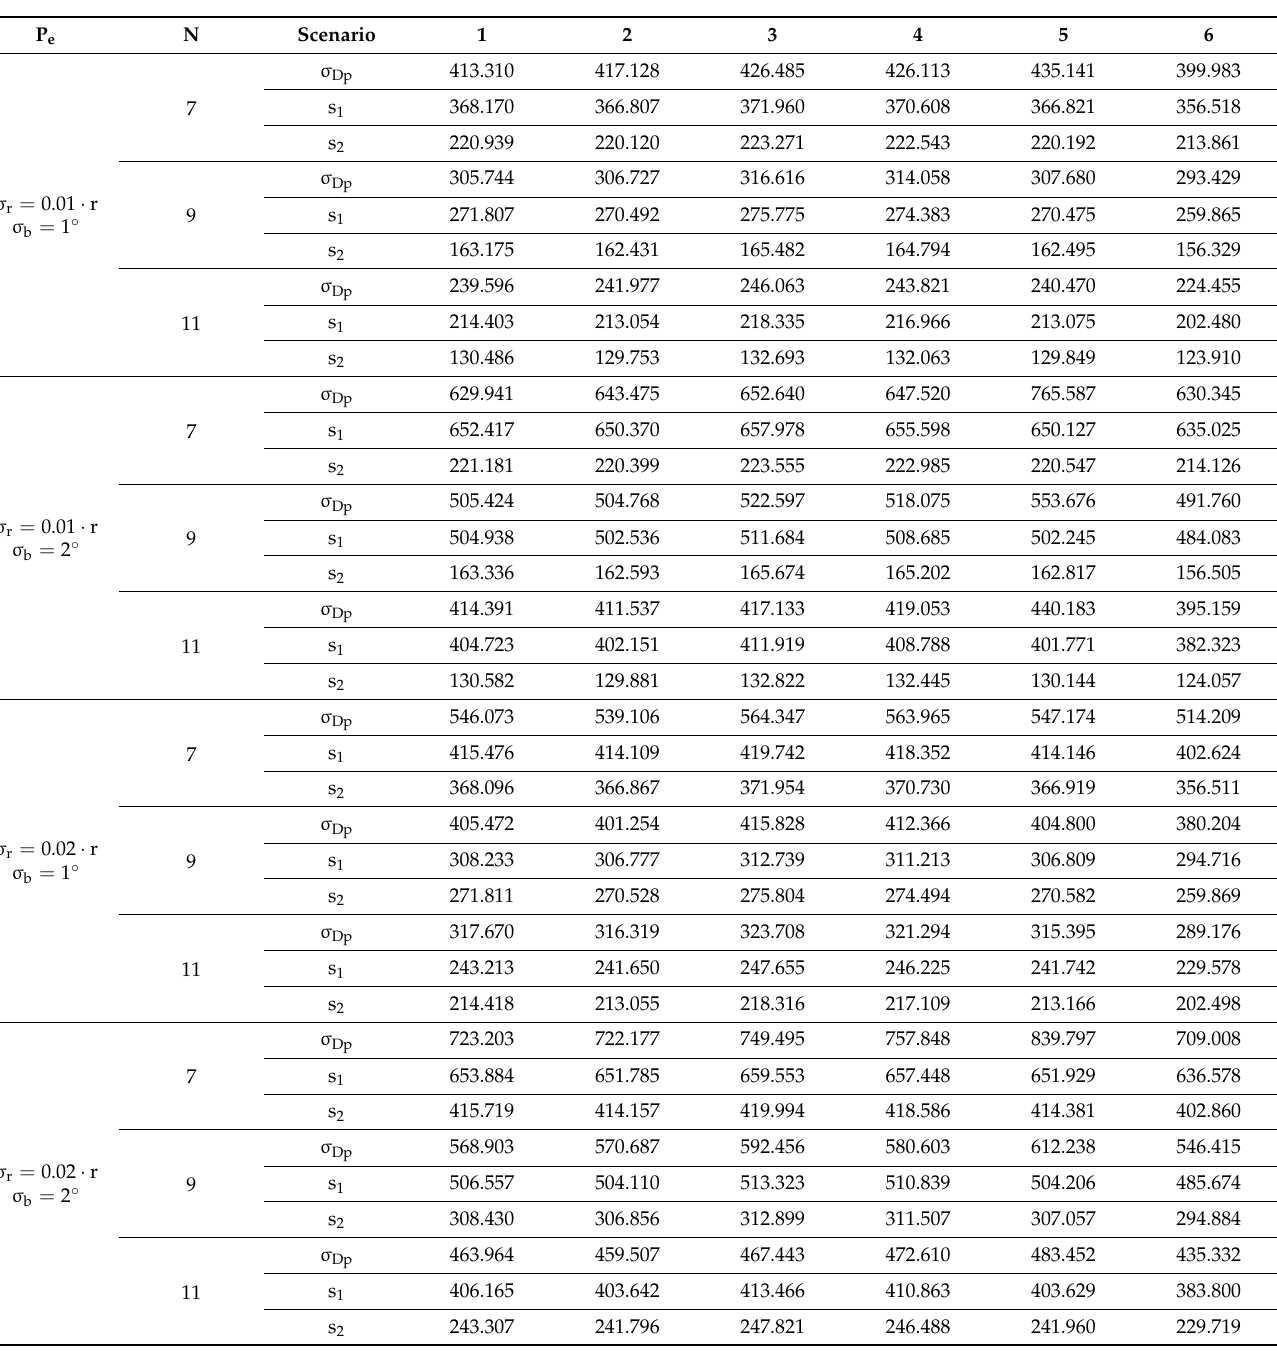
Table 2. RMSE of estimated position and AOU with different scenarios versus detection error values (close-range underwater